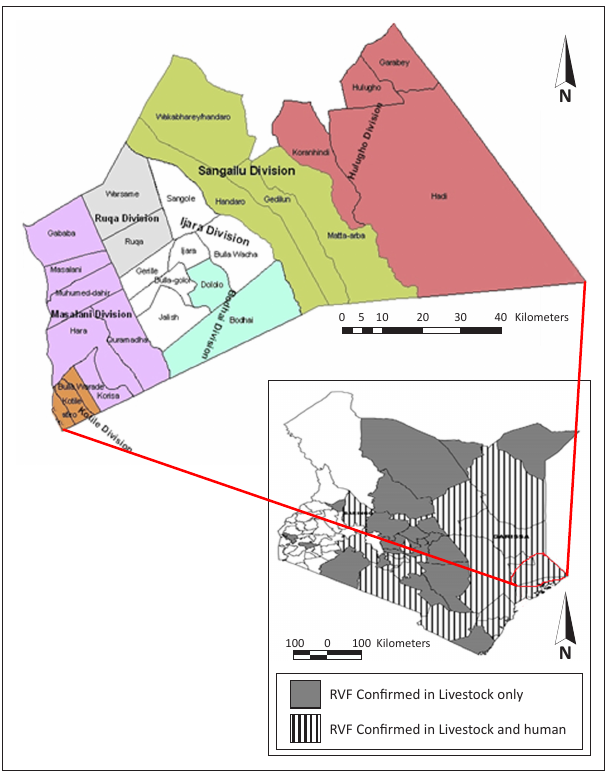
FIGURE 2: Map of Kenya showing Rift Valley fever endemicity and the relationship with the study area.